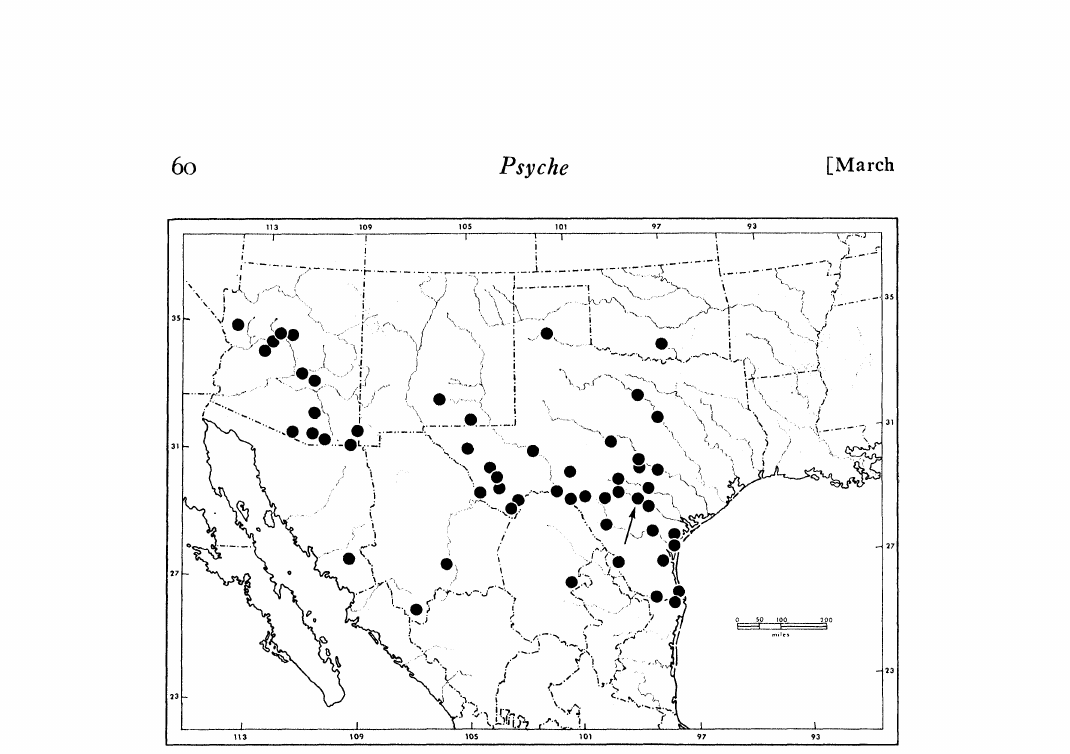
Fig. 7. Spatial distribution (based on material examined) of Celotes nessus southwestern United States and northern Mexico. Rivers and the borders of states are shown. Type locality indicated by